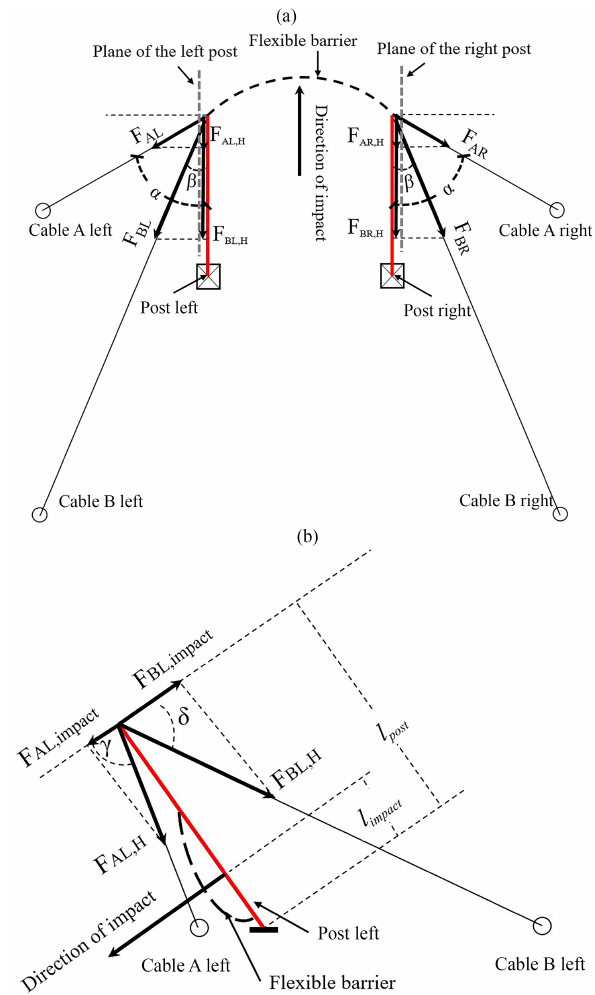
Figure 14. (a) Top view and (b) left-side view of sketches with the force analysis of the posts and